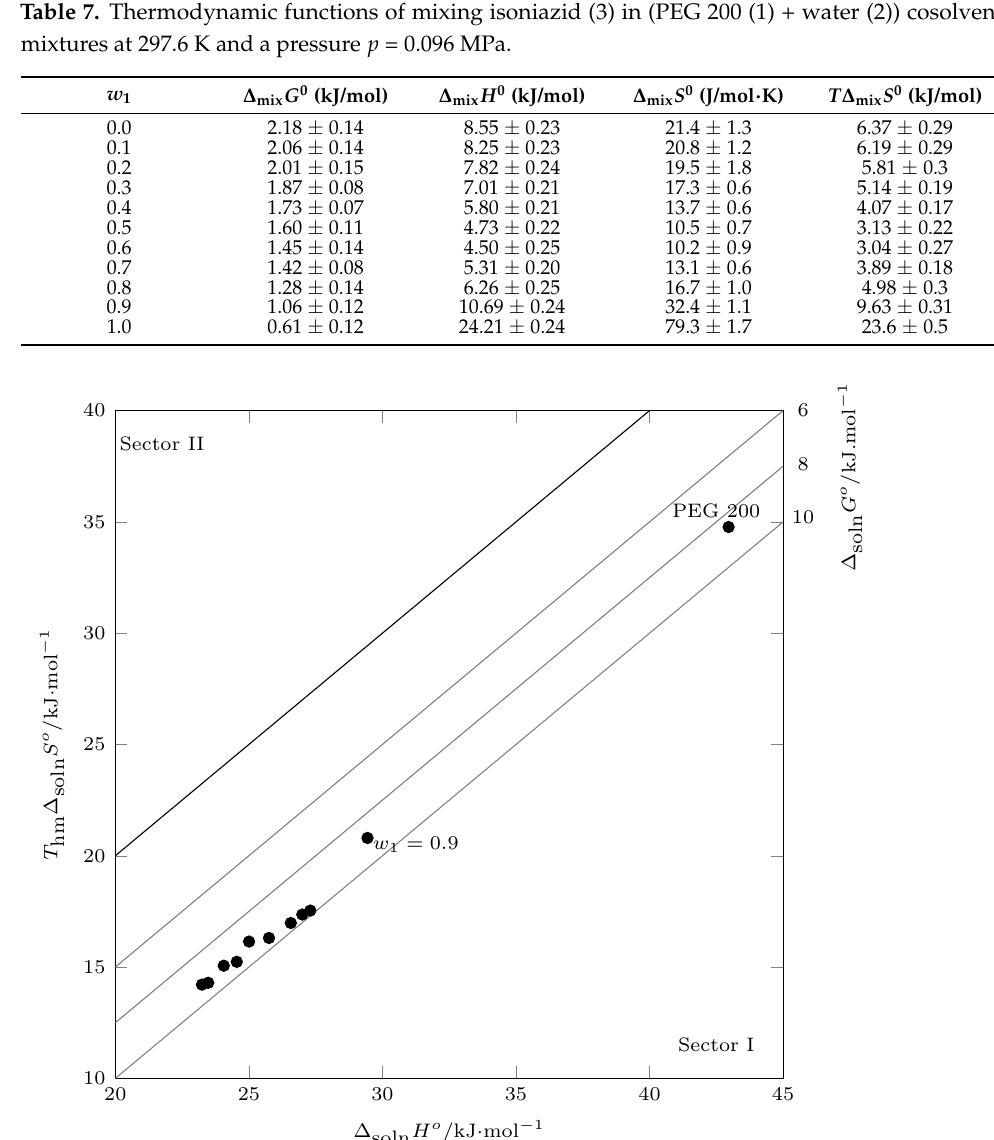
Figure 10. Relation between enthalpy ( ∆ mix H o ) and entropy ( T hm ∆ mix S o ) of the process mixing of isoniazid (3) in (PEG 200 (1) + water (2)) cosolvent mixtures at 297.6 K. The isoenergetic curves for ∆ o are represented by dotted mix G